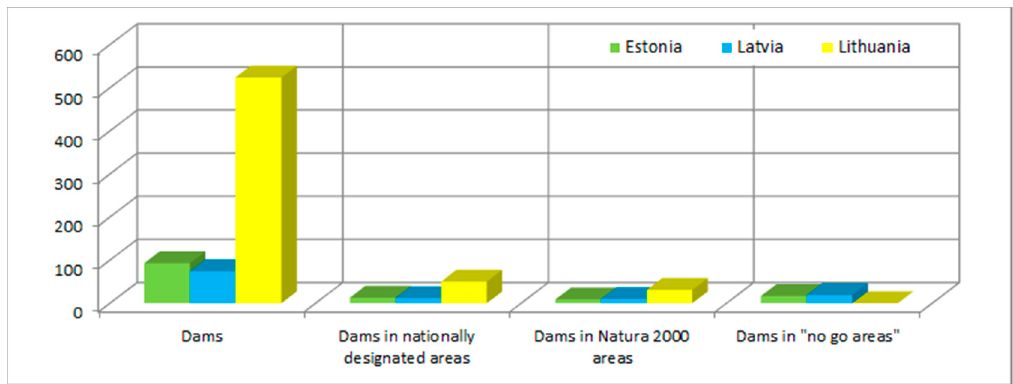
Figure 11. The number of existing nonpowered dams located in environmentally sensitive areas in the Baltic States.